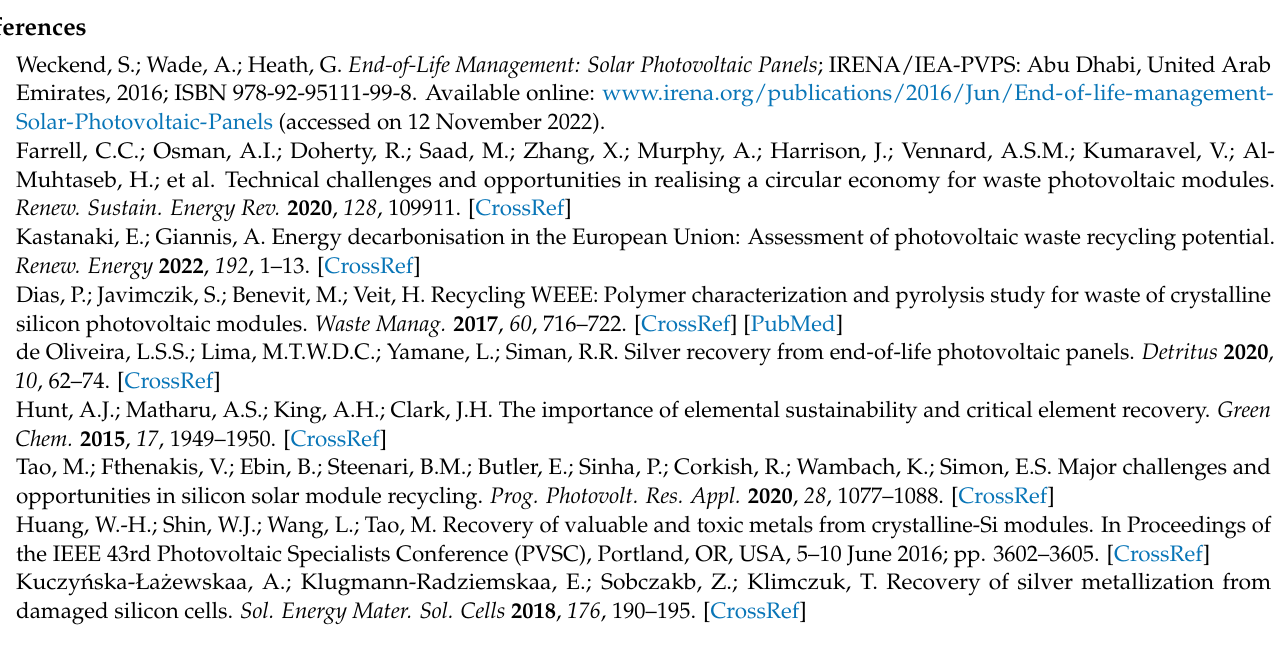
panel; Figure S3. The effect of stirring on Ag leaching (p-Si panel, HNO 3 2N, S/L=1/10, 2 h, 45 ◦ C); Figure S4. The effect of temperature on Al leaching (m-Si panel, HNO 3 2N, S/L=1/10); Figure